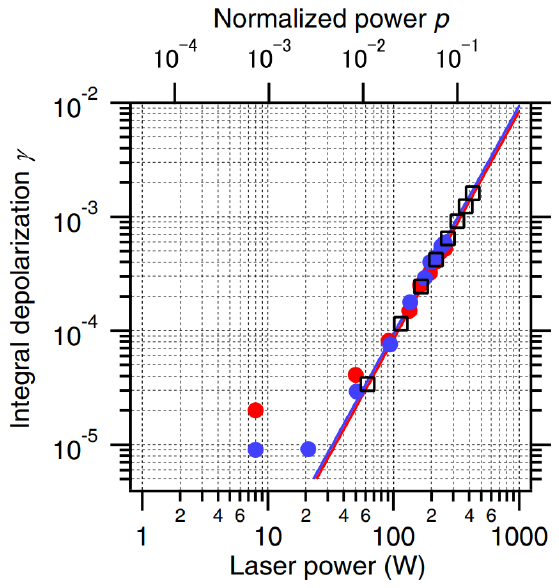
Figure 7. Experimental results of depolarization as a function of laser power (red and blue circles represent results for TGG ceramics with and without magnetic field, respectively; squares represent calculated results for TGG single crystals; solid lines represent theoretical curves) [48]. Reprinted with permission from Ref. [48]. Copyright 2014, copyright Optical Society of America.